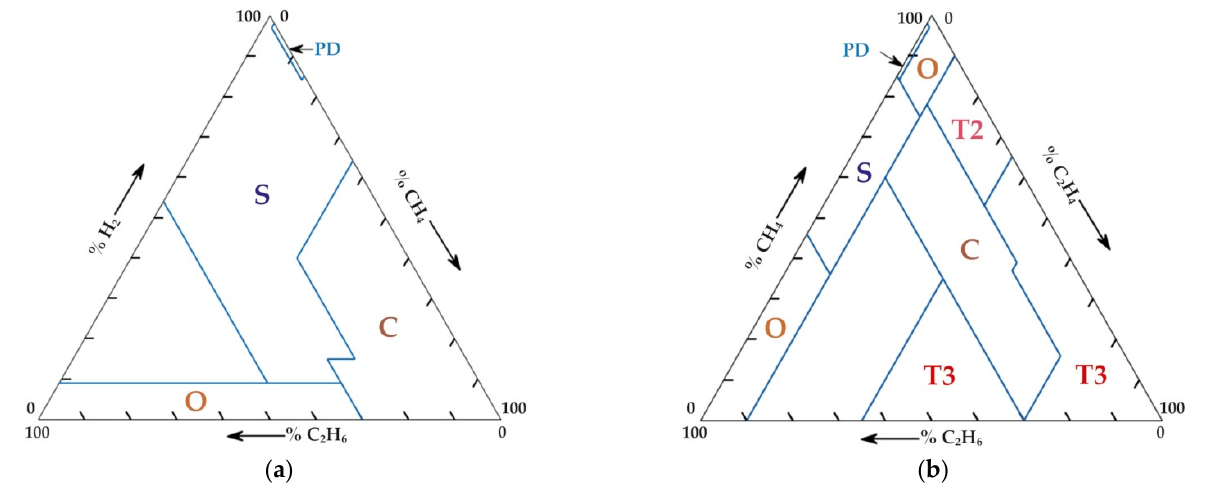
Figure 1. DTr-4 and DTr-5: ( a ) DTr-4 for low-temperature faults; ( b ) DTr-5 for thermal faults.